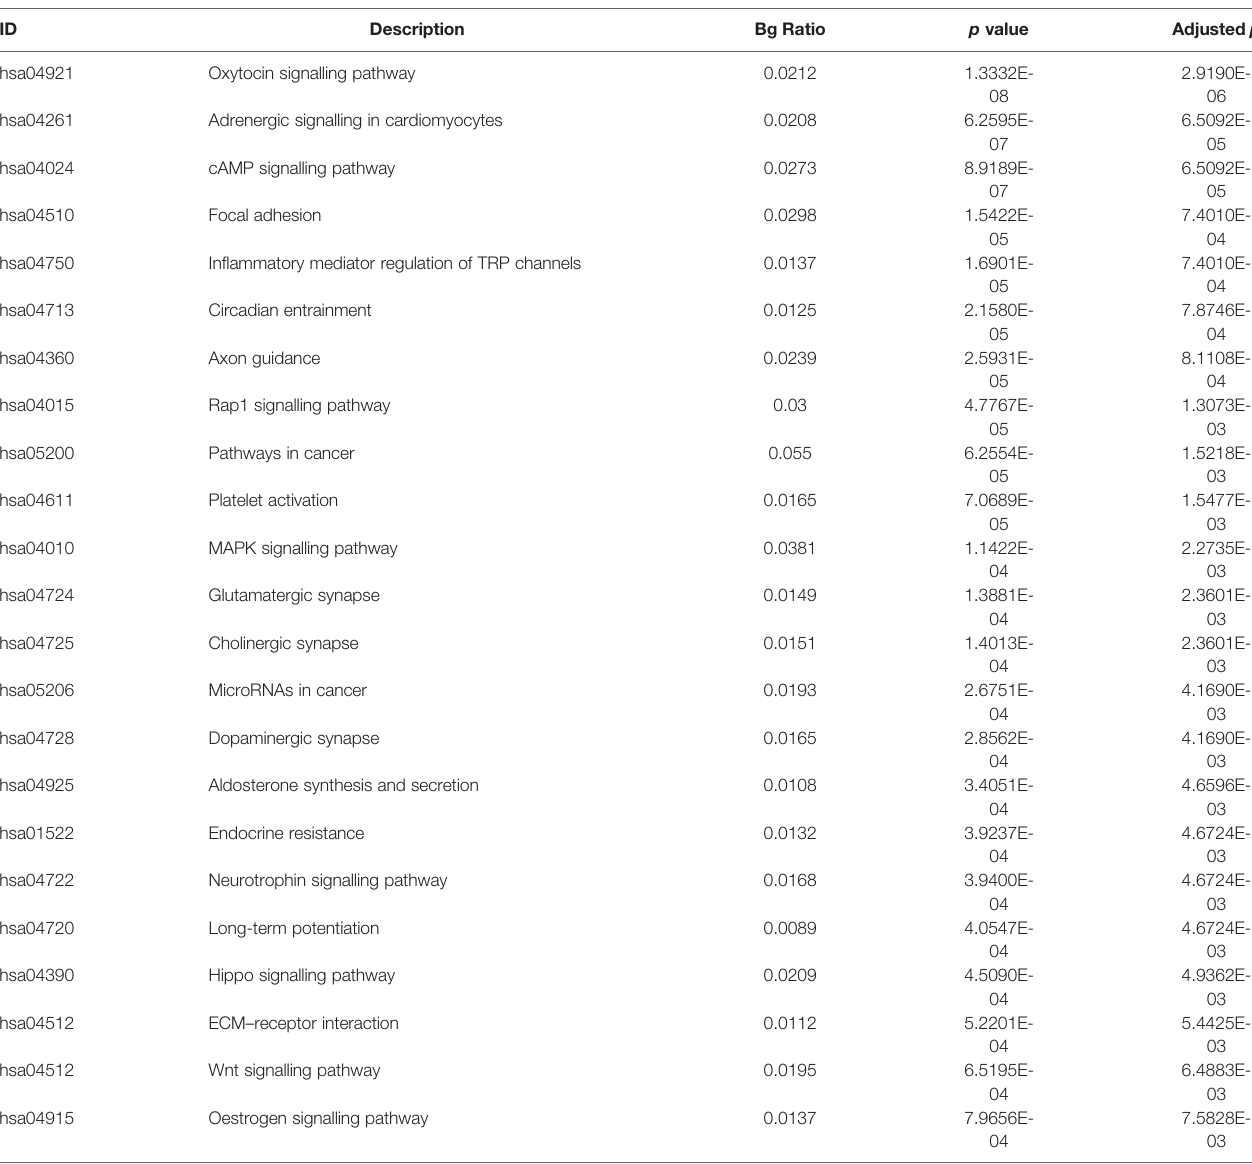
TABLE 7 | Pathway results of miRNAs in the ceRNA